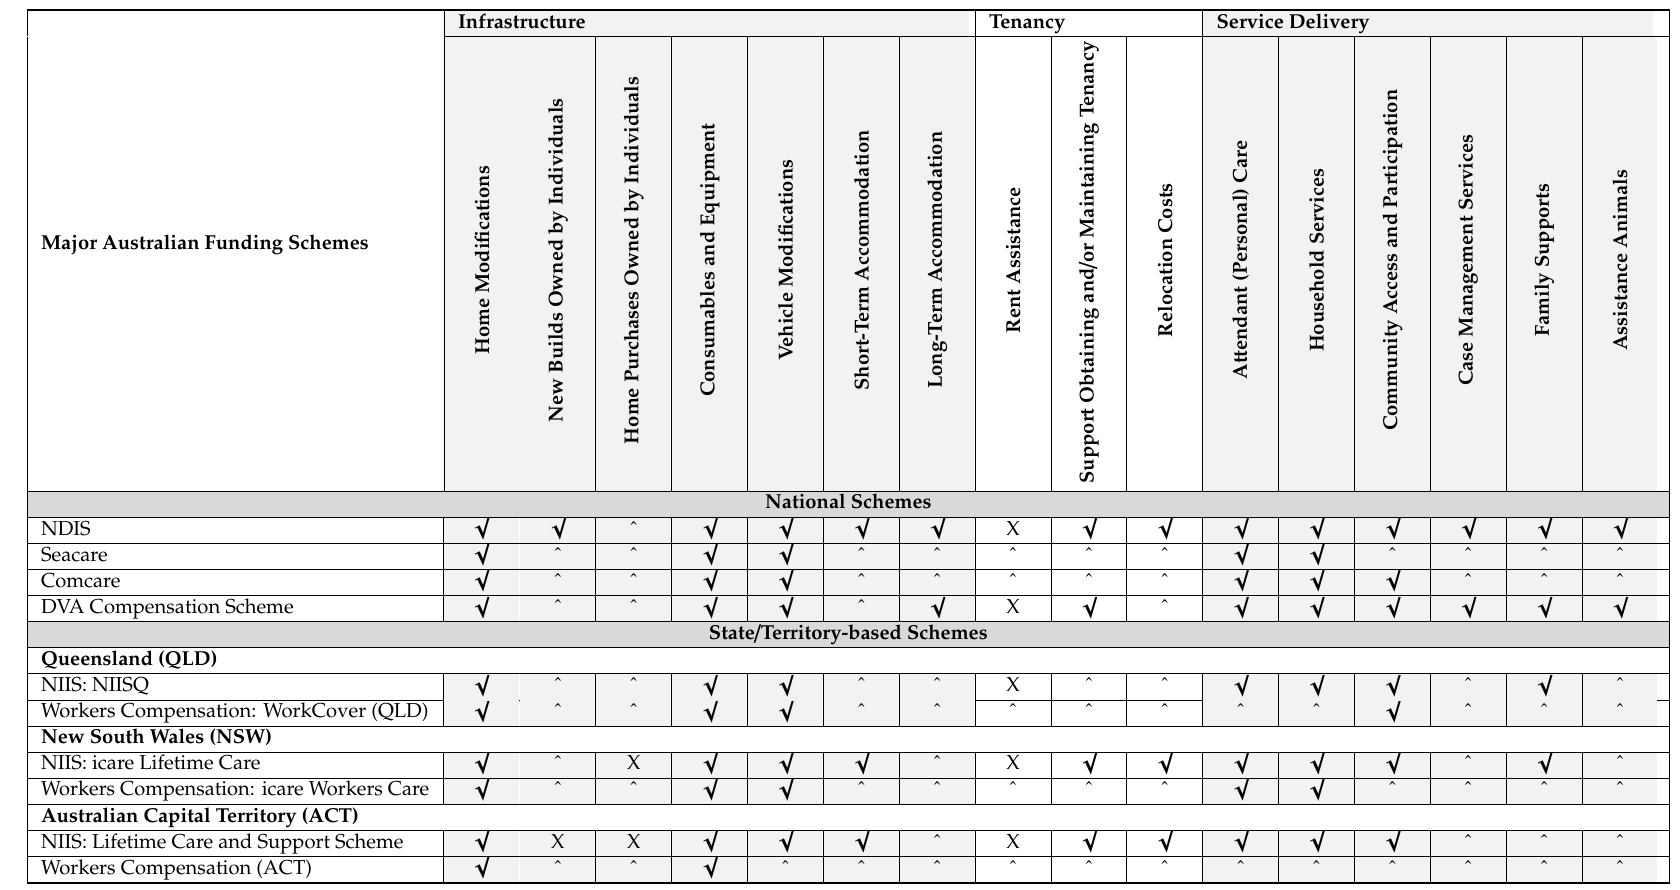
Table 1. Overview of Housing Support Funding for Australians with an Acquired Brain or Spinal Cord